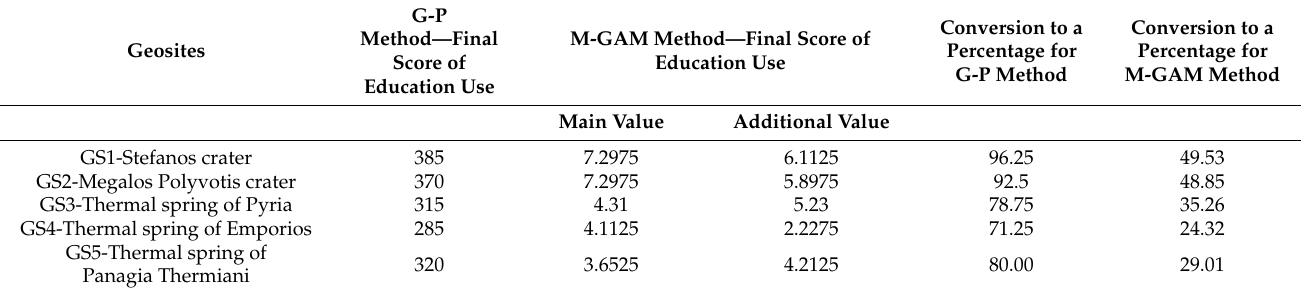
Table 9. Final results after the application of the two methods and after reduction to a common scale.